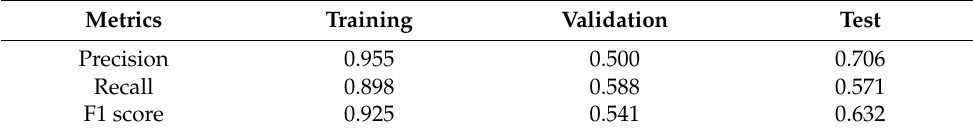
Table 2. Metrics for aspiration detection for all data sets.